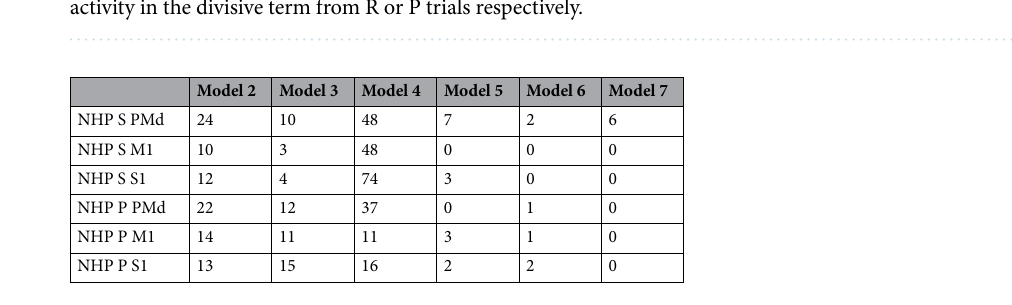
Table 5. Number of significant units with best model # (2–7), all were better than the linear model